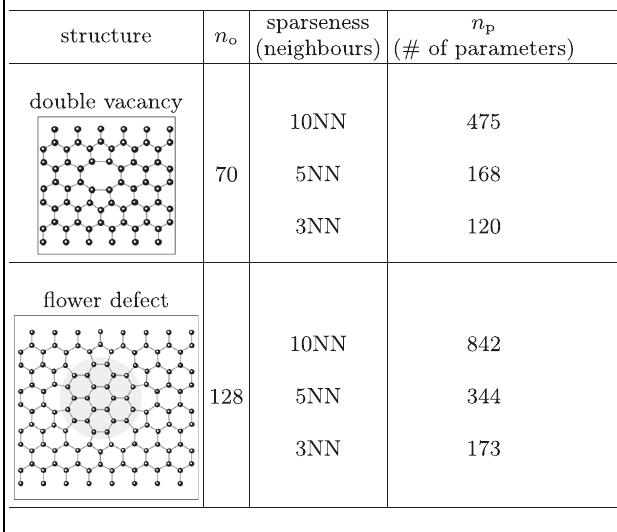
Table 2. Sparseness of TB parametrization: number of independent TB parameters for a given sparseness in both defect structures under